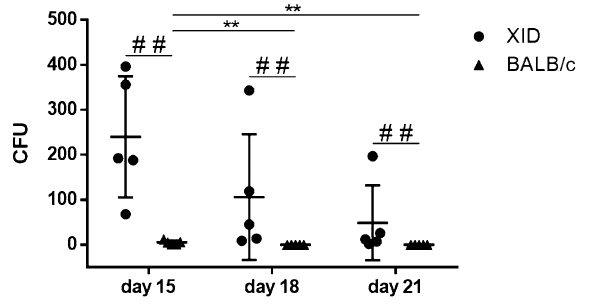
Figure 3. Investigation of the passage of C. gattii by the hematogenous route of XID and BALB/c mice. Counting of Colony Forming Units (CFU) of the peripheral blood of XID and BALB/c mice on days 15, 18, and 21 of the infectious course. Colony growth was not observed on days 3, 6, 9 and 12 (data not shown). The graphs show the results of 2 independent experiments (n = 5) ( ### p <